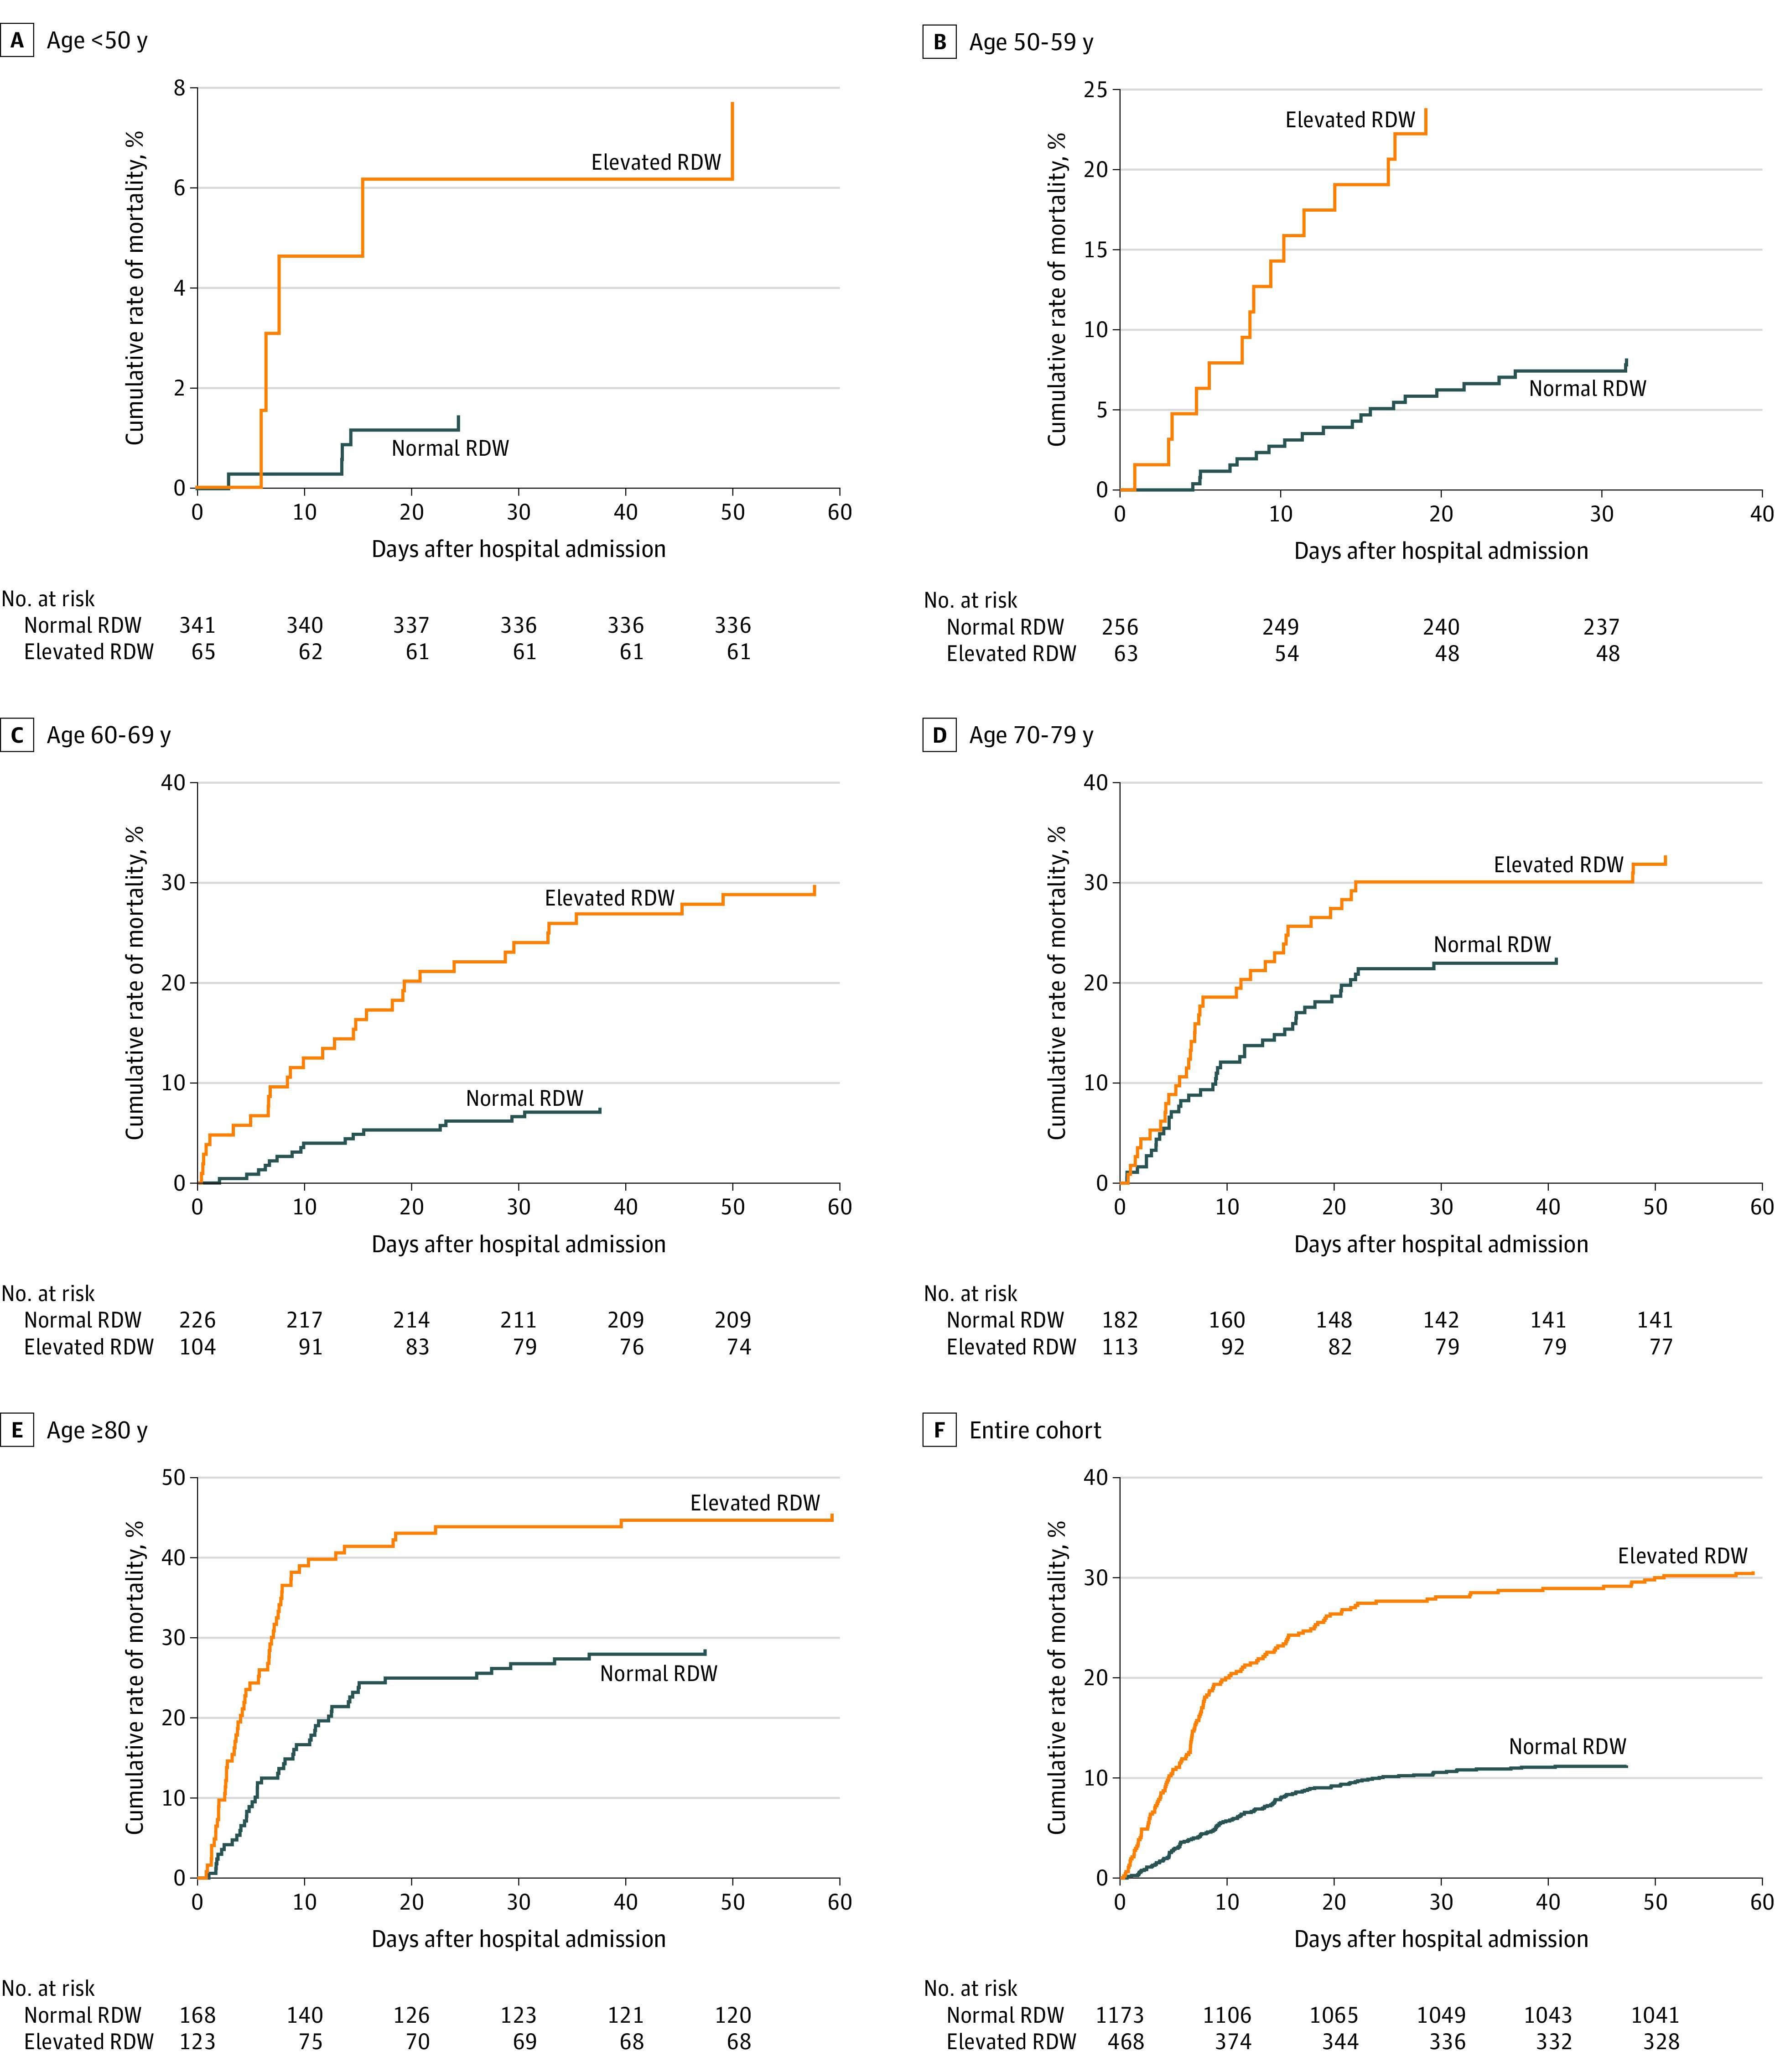
Elevated Red Blood Cell Distribution Width (RDW) at Hospital Admission and Mortality Among Patients With Coronavirus Disease 2019Across all age groups, an RDW greater than 14.5% measured at the time of admission was associated with a 31% mortality compared with an 11% mortality for patients whose RDW at admission was ≤14.5%. All increases in mortality are statistically significant except in the 70- to 80-year age group. Table 2 details age-stratified and RDW-stratified mortality rates.